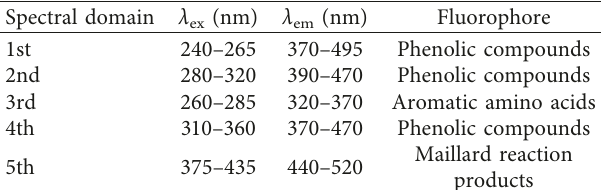
Table 1: Spectral regions showing characteristic fluorescence of honey fluorophores.